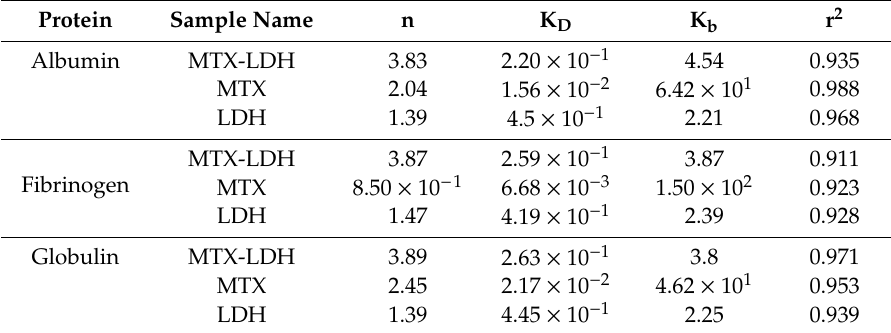
Table 1. Hill equation fitting results of the fluorescence quenching assay (PL excitation: 280 nm, emission: 360 nm). The curves in Figure 4 were fitted to the Hill plot utilizing linear